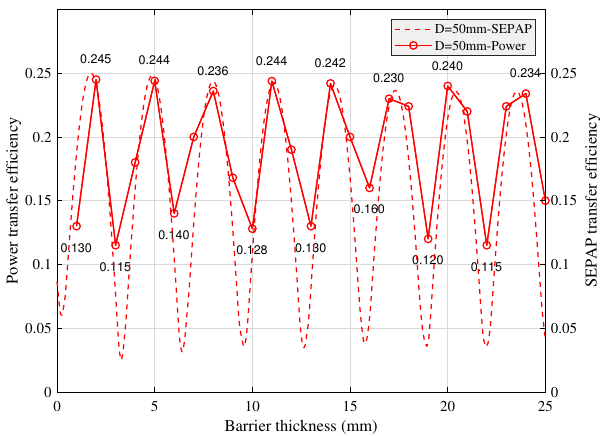
Figure 10. Relation between SEPAP and power transfer efficiencies over different barrier thickness.